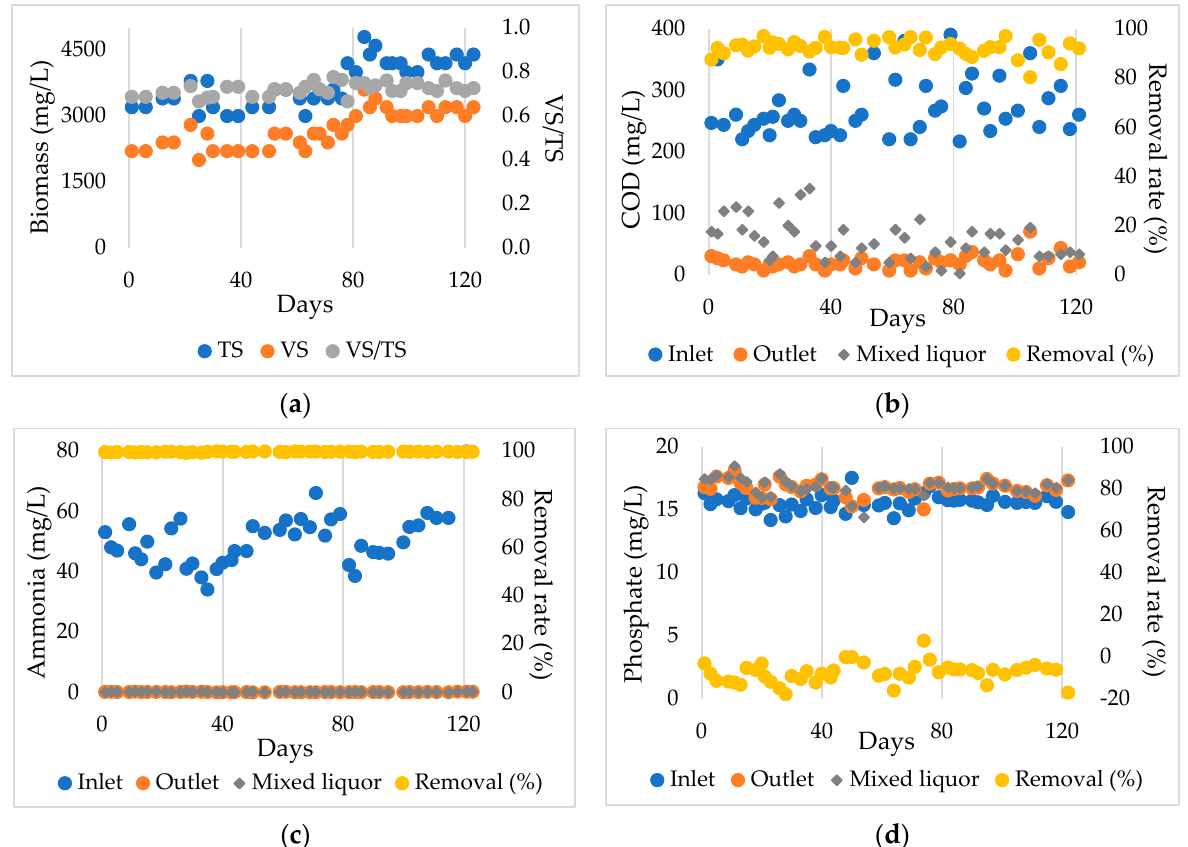
Figure 3. The evolution of biomass ( a ), COD ( b ), ammonia ( c ), and phosphate concentration ( d ) in MBMBR.